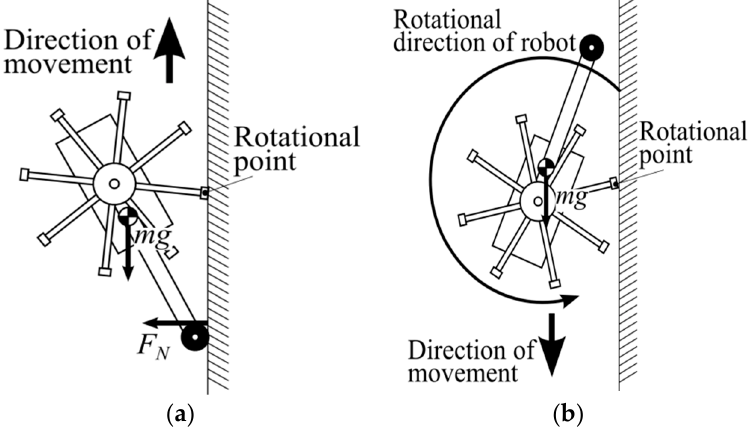
Figure 5. Attitude of the two-wheel-drive robot on the vertical wall. ( a ) Robot climbing wall; ( b ) robot moving down.